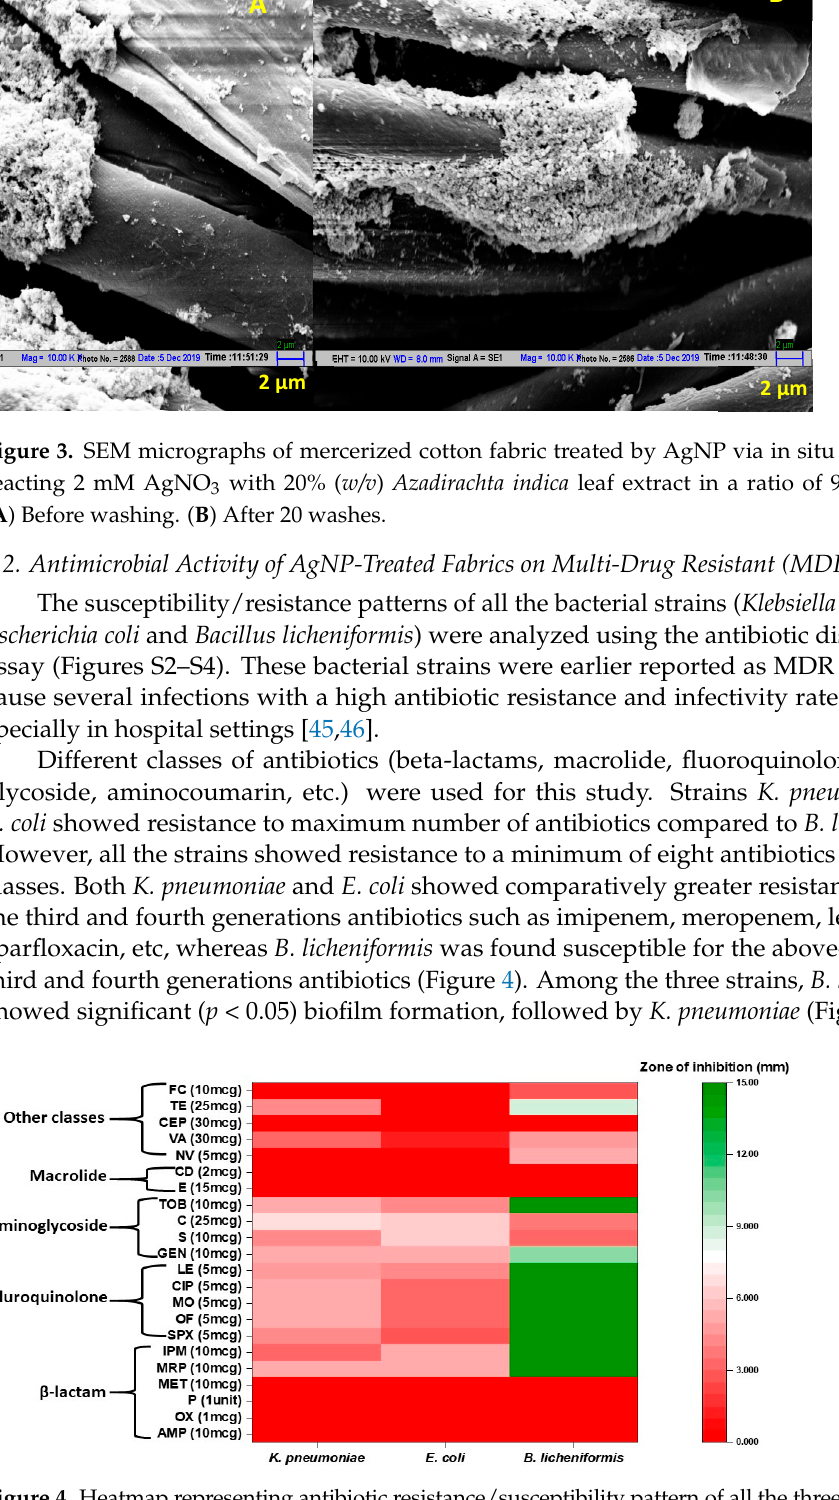
Figure 4. Heatmap representing antibiotic resistance/susceptibility pattern of all the three test bac- teria.